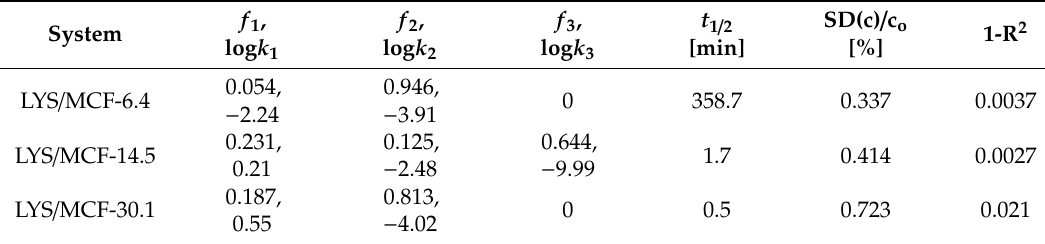
Table 3. Optimized parameters of m-exp